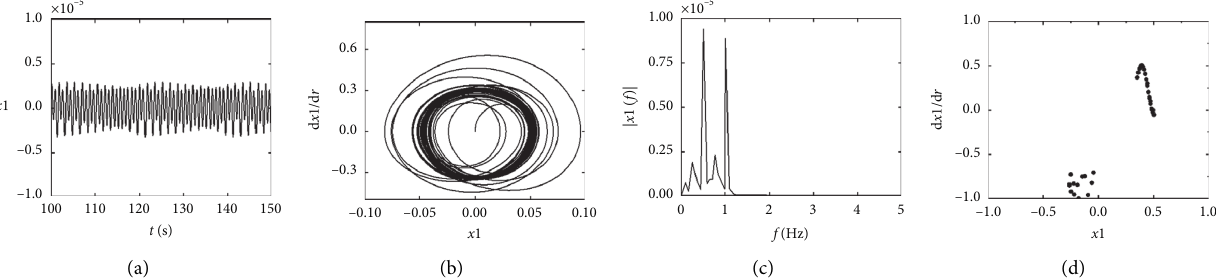
Figure 13: Numerical analysis results at ω � 4000rad/s, k and (d) Poincare map.